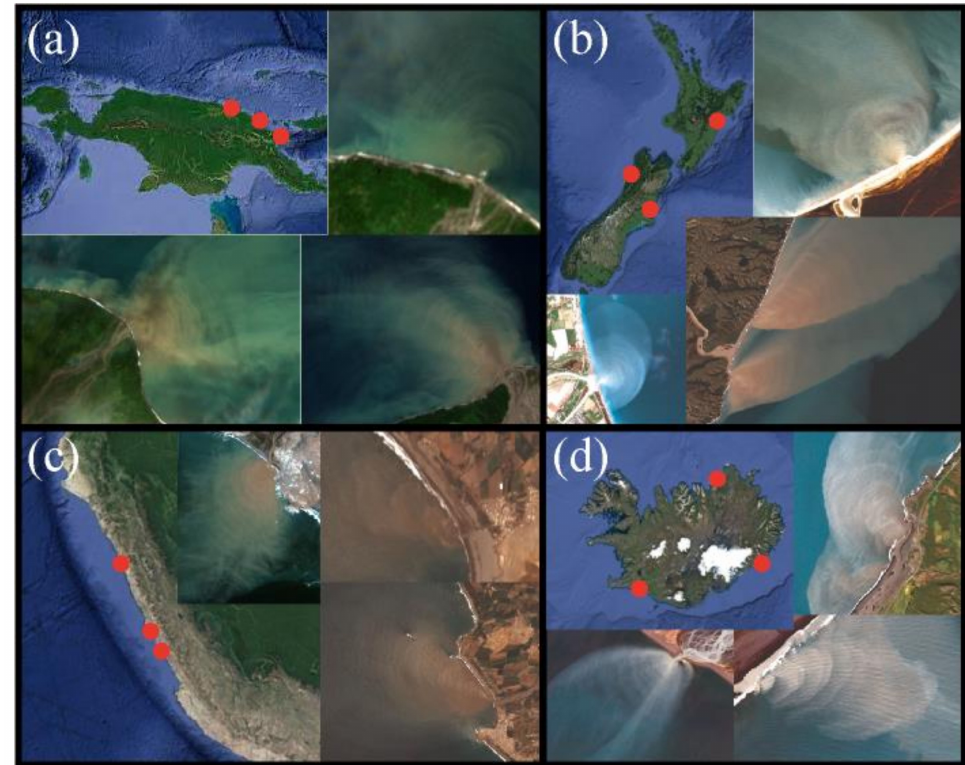
Figure 11. Satellite images (Sentinel-2) of concentric rings—surface manifestations of high-frequency internal waves in river plumes—in ( a ) New Guinea, ( b ) New Zealand, ( c ) Peru, ( d ) Iceland. The red dots indicate locations of the presented river plumes. Note that the images are given in different spatial